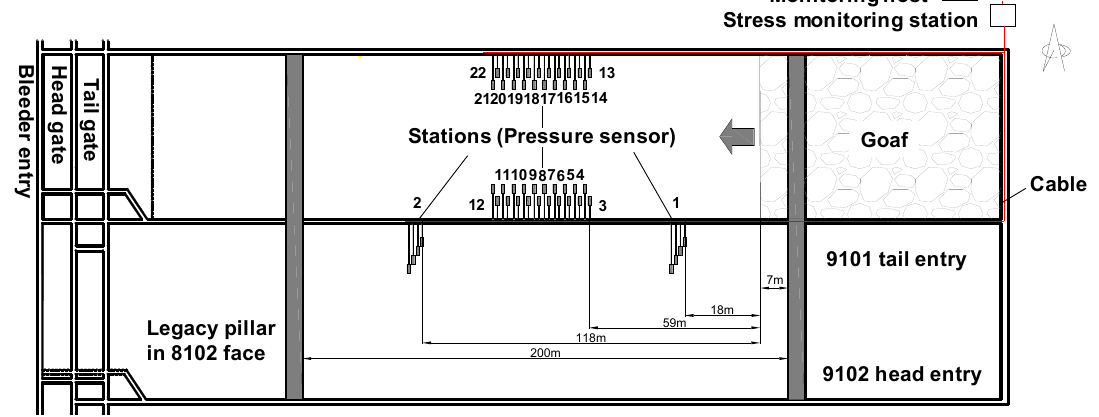
Figure 16. Layout of the 9101 working face and real-time monitoring system.